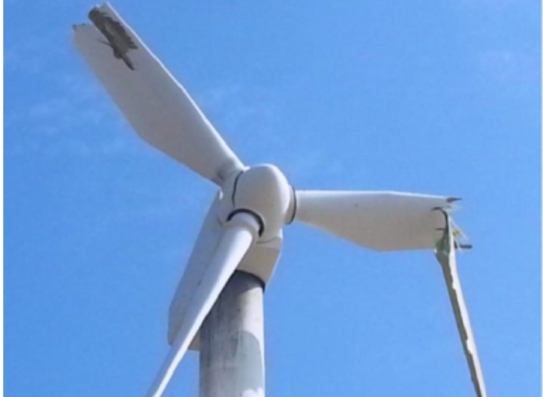
Figure 3. Photograph showing blade damage due to Typhoon Usagi